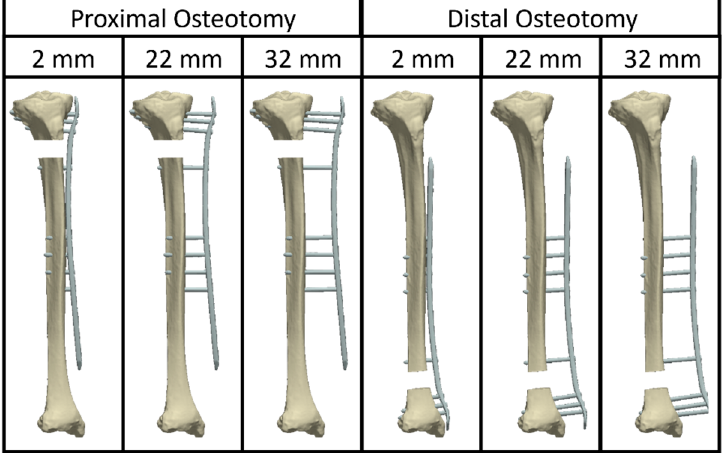
Figure 4. Anterior view of bone-plate constructs with an unstable, meta-diaphyseal, either proximal ( left images) or distal ( right images) tibial fracture, mimicked via osteotomizing a 20 mm gap and fixed with three different plate elevations. While the 2 mm plate elevation represents internal fixation, the 22 mm and 32 mm elevations represent externalized locked plating with soft tissue thicknesses of 20 mm and 30 mm, respectively.